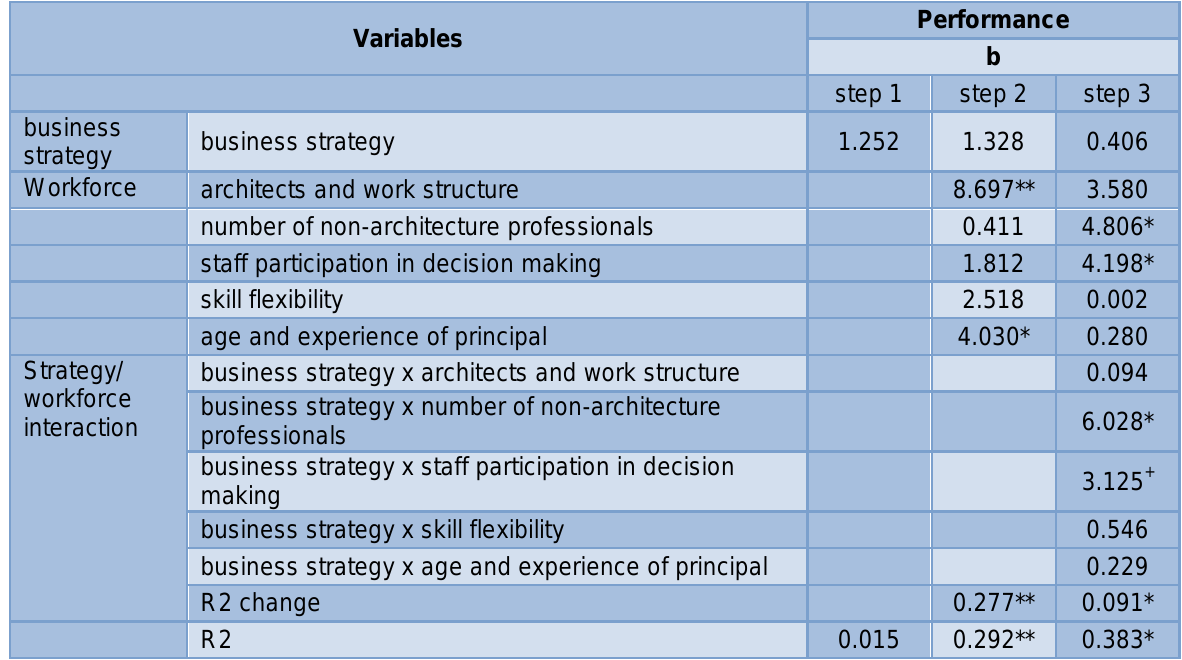
Table 3 Results of simultaneous hierarchical regression analysis for